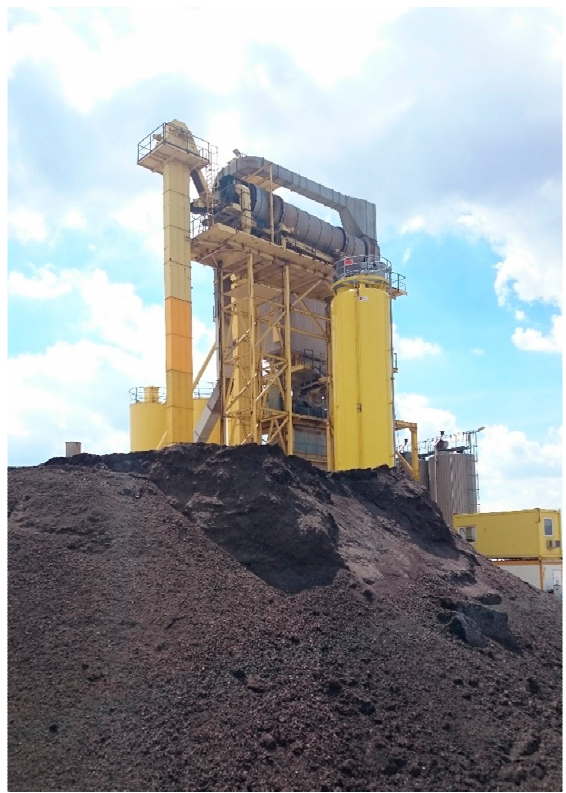
Figure 1. Asphalt plant with a reclaimed asphalt pavement (RAP) drum on the top and view of the RAP pile.